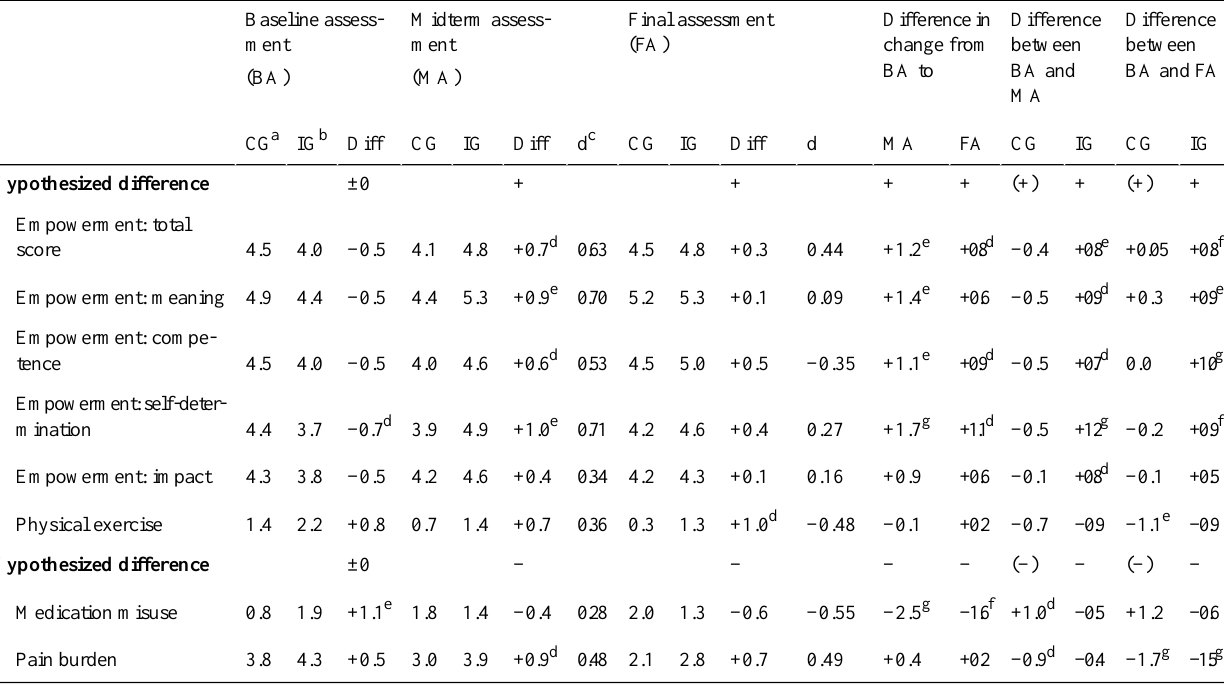
Table 2. Means, mean differences, and significance levels for outcome measures within and between two experimental